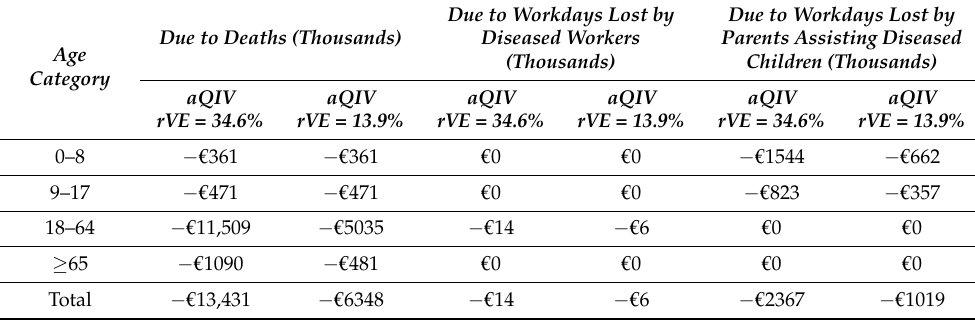
Table A2. Total (population) incremental indirect costs (productivity losses).